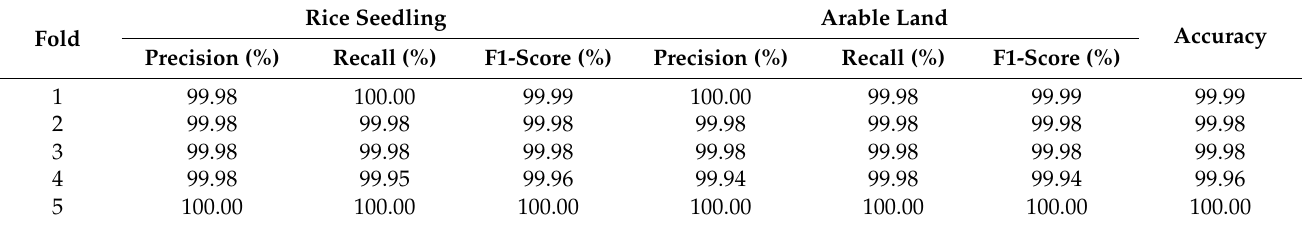
Table 7. Model evaluation on five divisions of cross-validation datasets.